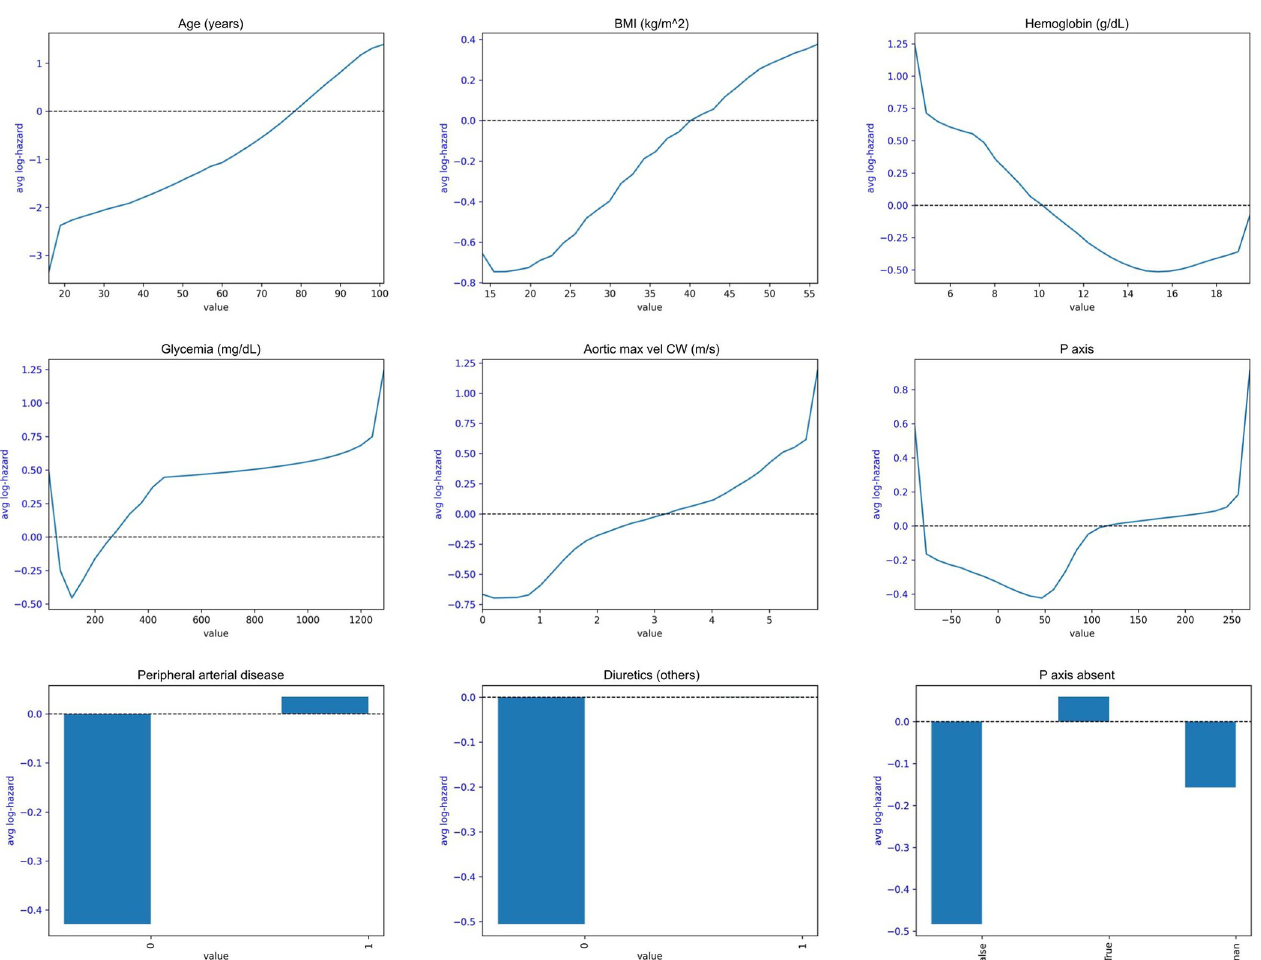
Fig 3. Partial dependence plots for PHNN model. The blue line (or bar for categorical values) represents the value of the log hazard for various values of the covariate (x axis). Higher values correspond to higher hazard.